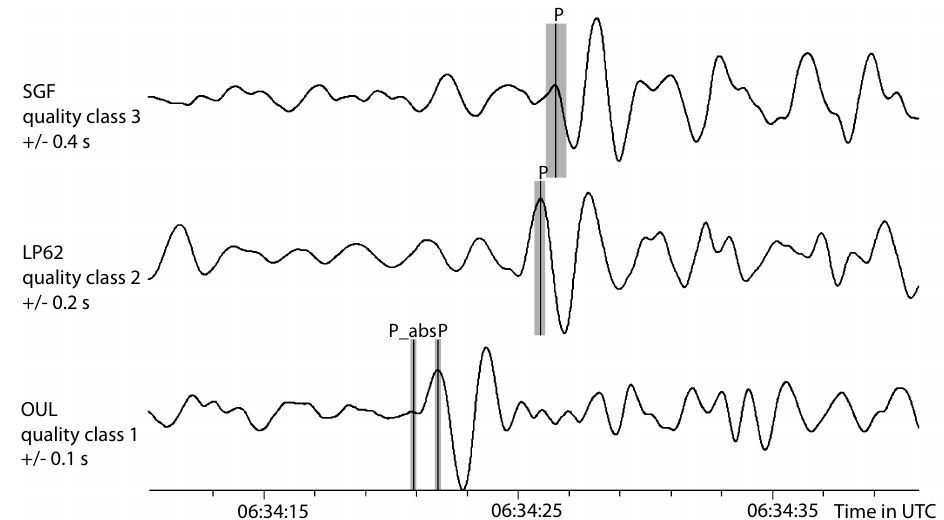
Figure 3. Example travel time picks of different quality from the same event observed at three different stations. The recorded waveforms have been filtered with the WWSSN short period simulation filter. The travel time observation from the station OUL was attributed a quality class 1, the one from station LP62 a quality class 2, and from station SGF a quality class 3. For OUL, the absolute travel time ( P abs ) was picked as well as the relative travel time ( P ). For each pick, the timing uncertainty estimate of the quality class is shown with a grey rectangle. Table 1. The travel time data quality classes. The table shows the data quality classes, the corresponding error estimates, and the number of travel time residual in the quality class for POLENET/LAPNET data, SVEKALAPKO data, and the total. The bottom row shows the total number of travel time residuals over all quality classes for both projects, and finally the total number of travel time residuals in our database. Quality Error Number of Number of Total number class estimate (s) POLENET/LAPNET